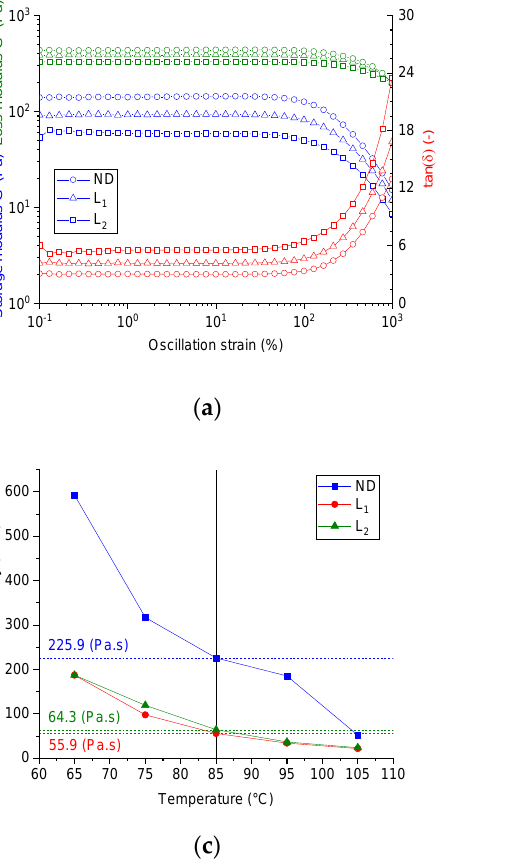
Figure 2. ( a ) Deformation sweep test of the spinning dopes at 85 °C; ( b ) master curves of the complex viscosity versus the angular frequency of the spinning dopes at a reference temperature of 85 °C; ( c ) plot of the zero-shear viscosity versus the temperature for all studied spinning dopes; ( d ) plot of relaxation time of the dopes versus temperature.